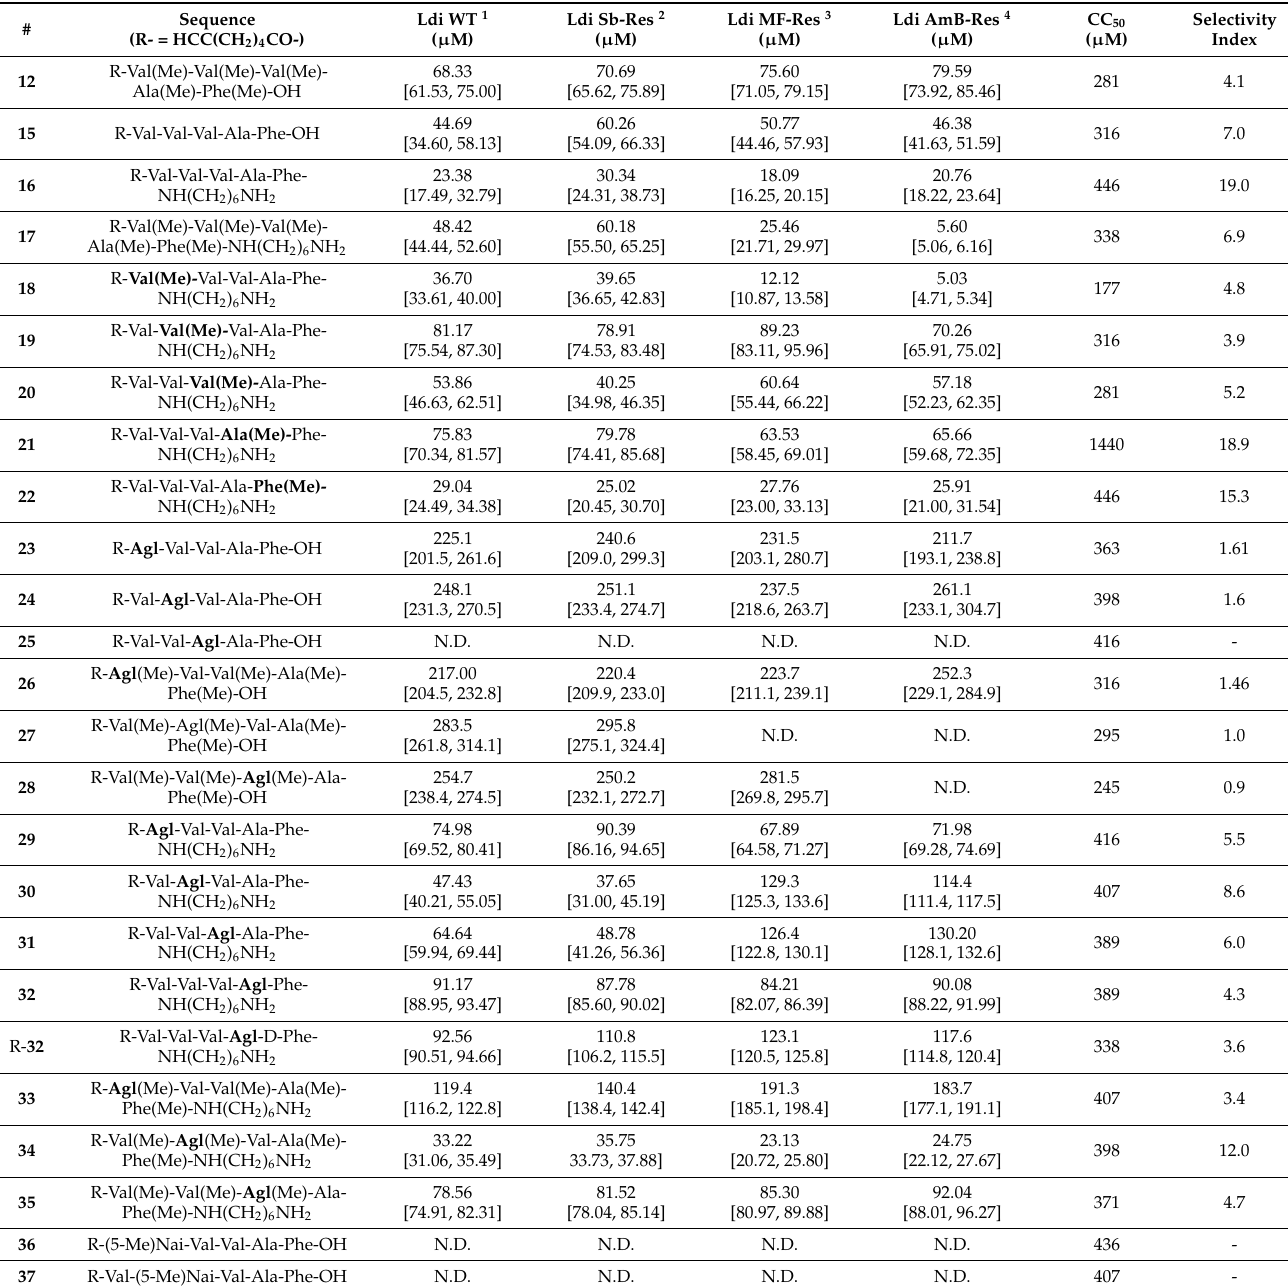
24 h. Most analogs exhibited CC 50 values between 170–450 µ M. Exceptionally, MeAla peptide amide 21 was 3.2- to 8-fold less toxic than the other peptide analogs. Comparing macrophage toxicity with potency against L. infantum , the selectivity index (SI) for MeAla peptide amide 21 was relatively high (SI = 19.1) and comparable with the most potent peptide (e.g., 16 , SI = 19.2). In comparisons of macrophage toxicity with potency against the AmB resistant Leishmania strain, permethylated and MeVal 1 peptide amides 17 and 18 exhibited, respectively, therapeutic indices of 64 and 36. Table 2. Structure, bioactivity of almiramide derivatives on different strains of Leishmania (EC 50 ) and cytotoxicity of peptides 12 – 39